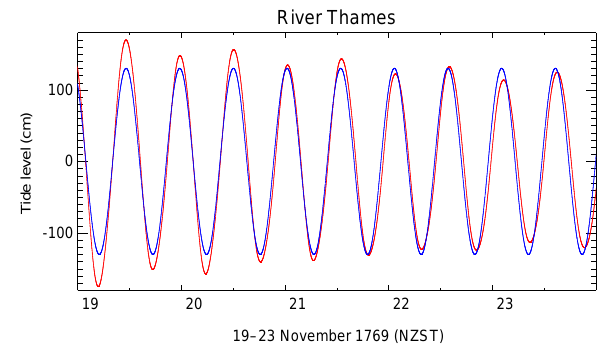
Figure 3. The predicted tide during 19–23 November 1769 at Rocky Point at the head of the River Thames, New Zealand, us- ing a full set of tidal constituents (red) or the M2 constituent only (blue). Mean time at this longitude (175 ◦ 31 (cid:48) E) is 18min behind New Zealand standard time (NZST), which is 12h east of Green-